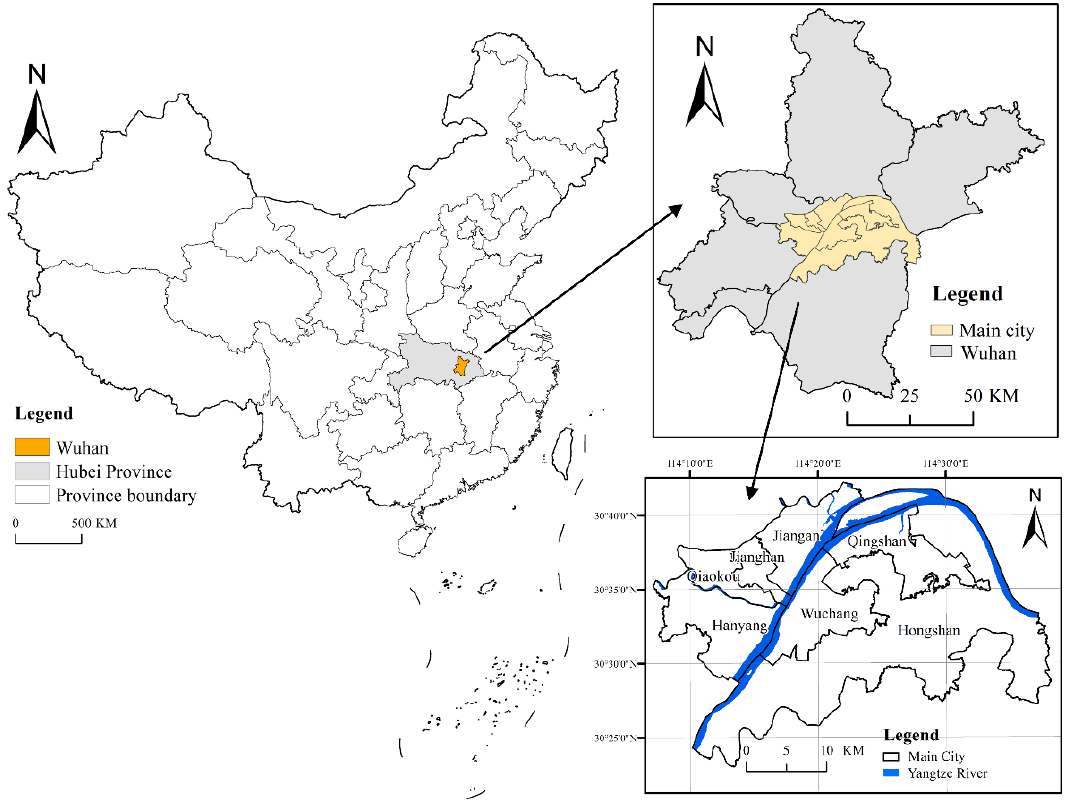
Figure 1. Location of the study area.